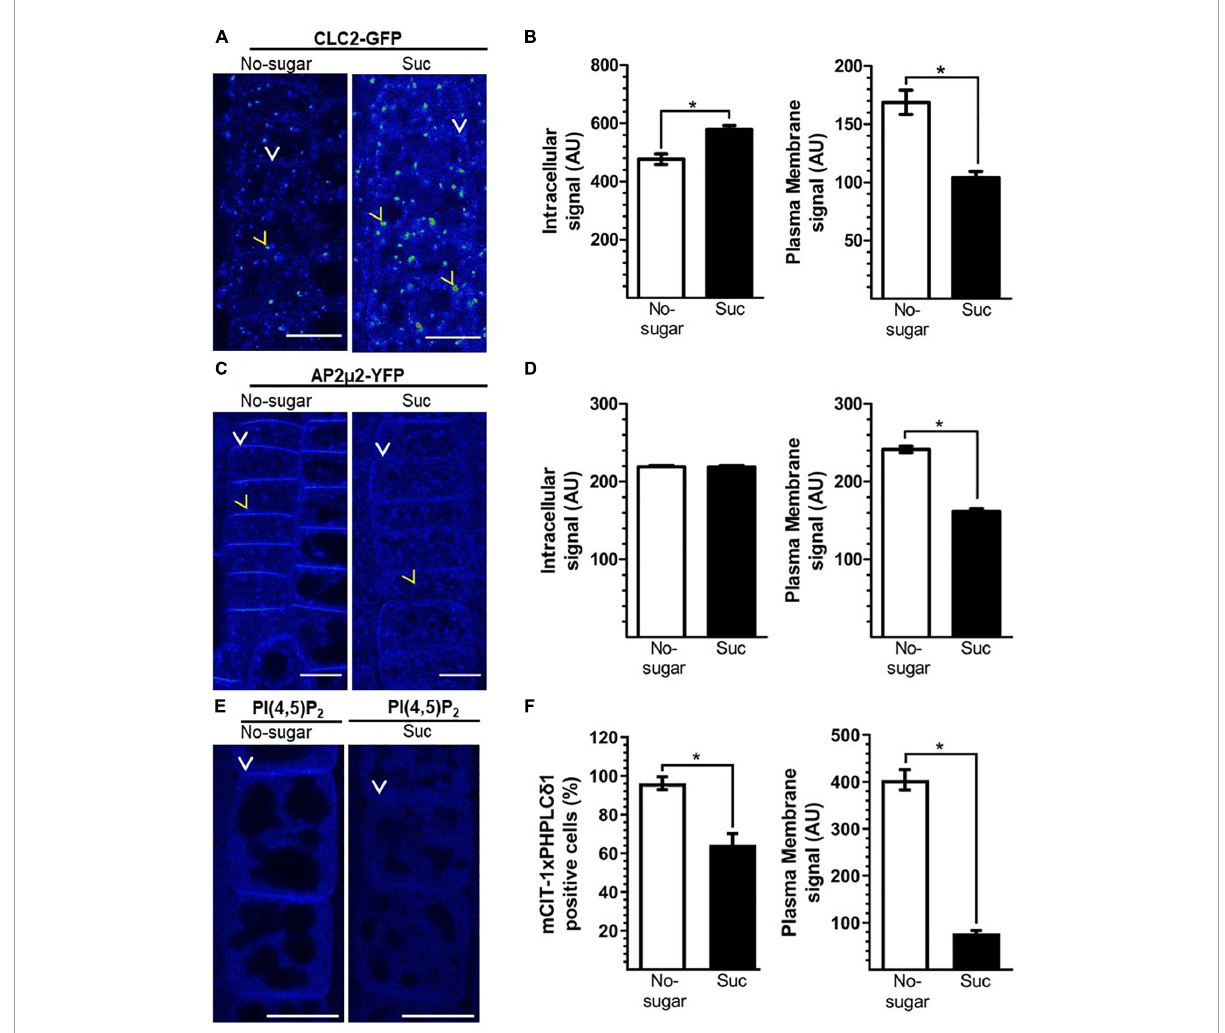
FIGURE3 Sucrose modulates clathrin-mediated endocytosis (CME). Transgenic Arabidopsis seeds were sown on sugar-free (No-sugar) or sucrose-supplemented (60 mM, Suc) solid medium. After 7 days, seedling root epidermal cells were visualized by confocal microscopy. (A,C) Cellular distribution of key CME molecular players CLC2-GFP (A) AP2 µ 2-YFP (C) and the PI(4,5)P 2 biosensor (E) . (A,C,E) Representative images are shown using the Rainbow RGB LUT (Fiji) of n = 15 seedlings in each condition. Yellow arrowheads and white arrows indicate endosomes and the plasma membrane, respectively. Bar, 10 µ m. (B,D) Fluorescent signal at the intracellular and plasma membrane compartments was quantified in CLC2-GFP (B) AP2 µ 2-YFP (D) seedlings. (F) Fluorescent signal of the PI(4,5)P 2 biosensor at the plasma membrane was quantified in mCIT-1xPH PLC δ 1 seedlings. The number of analyzed cells that display plasma membrane fluorescence over the background are compared (F) . AU: arbitrary unit. Error bars represent standard error for three independent biological replicates ( n = 15 seedlings). Two-tailed Student’s t -test; * p <